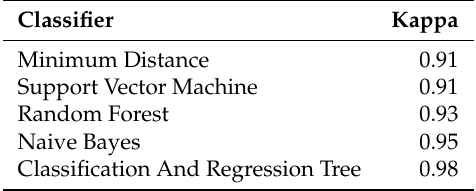
Table 6. Classifier accuracy for different classifiers using the kappa